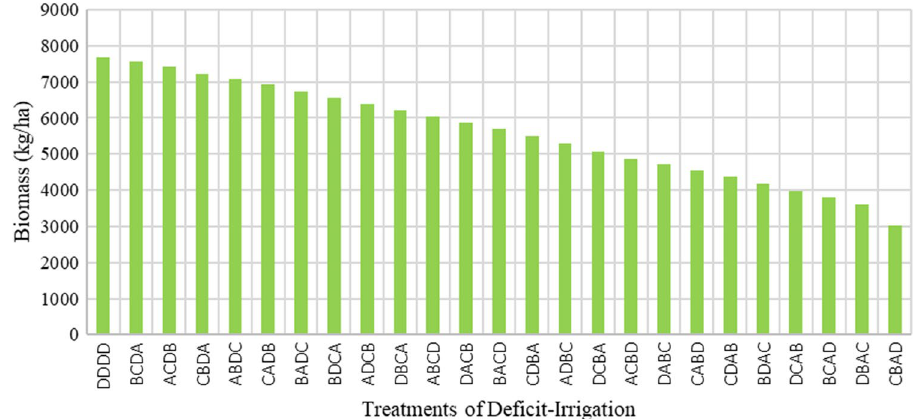
Fig. 3 Average biomass of